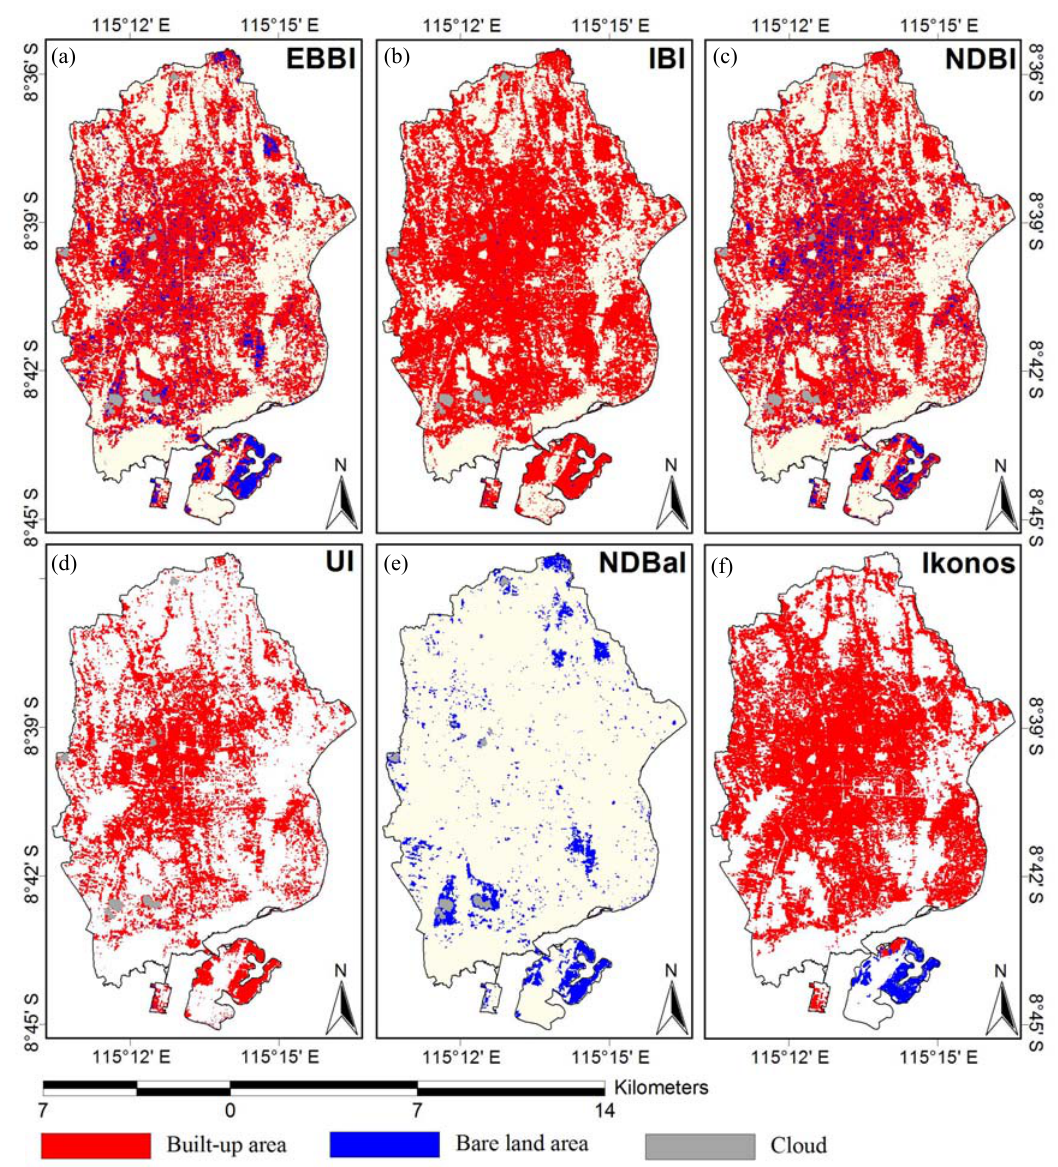
Figure 3. The spatial distribution of built-up areas and bare land is shown for each type of index/remote sensing data transformation: ( a ) EBBI, ( b ) IBI, ( c ) NDBI, ( d ) UI, ( e ) NDBaI, and ( f ) IKONOS imagery.